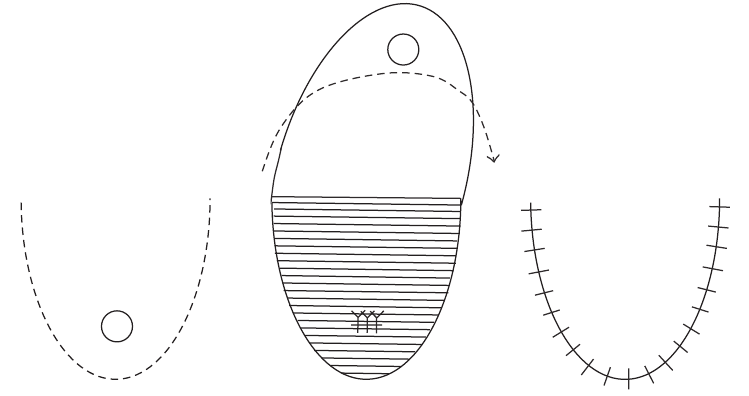
Figure 2: Rectal advancement flap